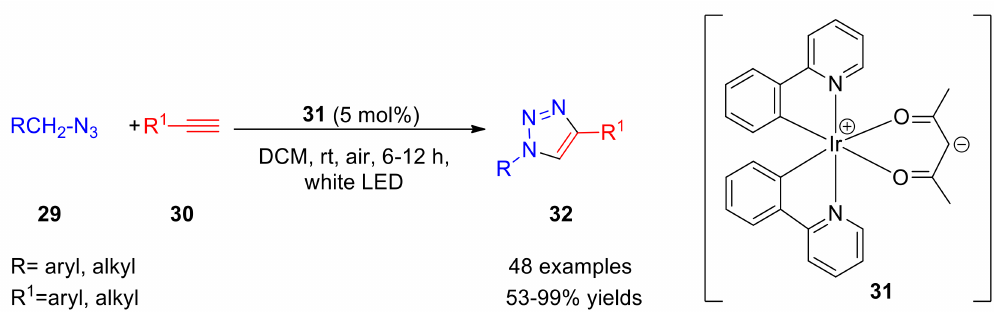
Scheme 11. PcAAC by an iridium complex 31